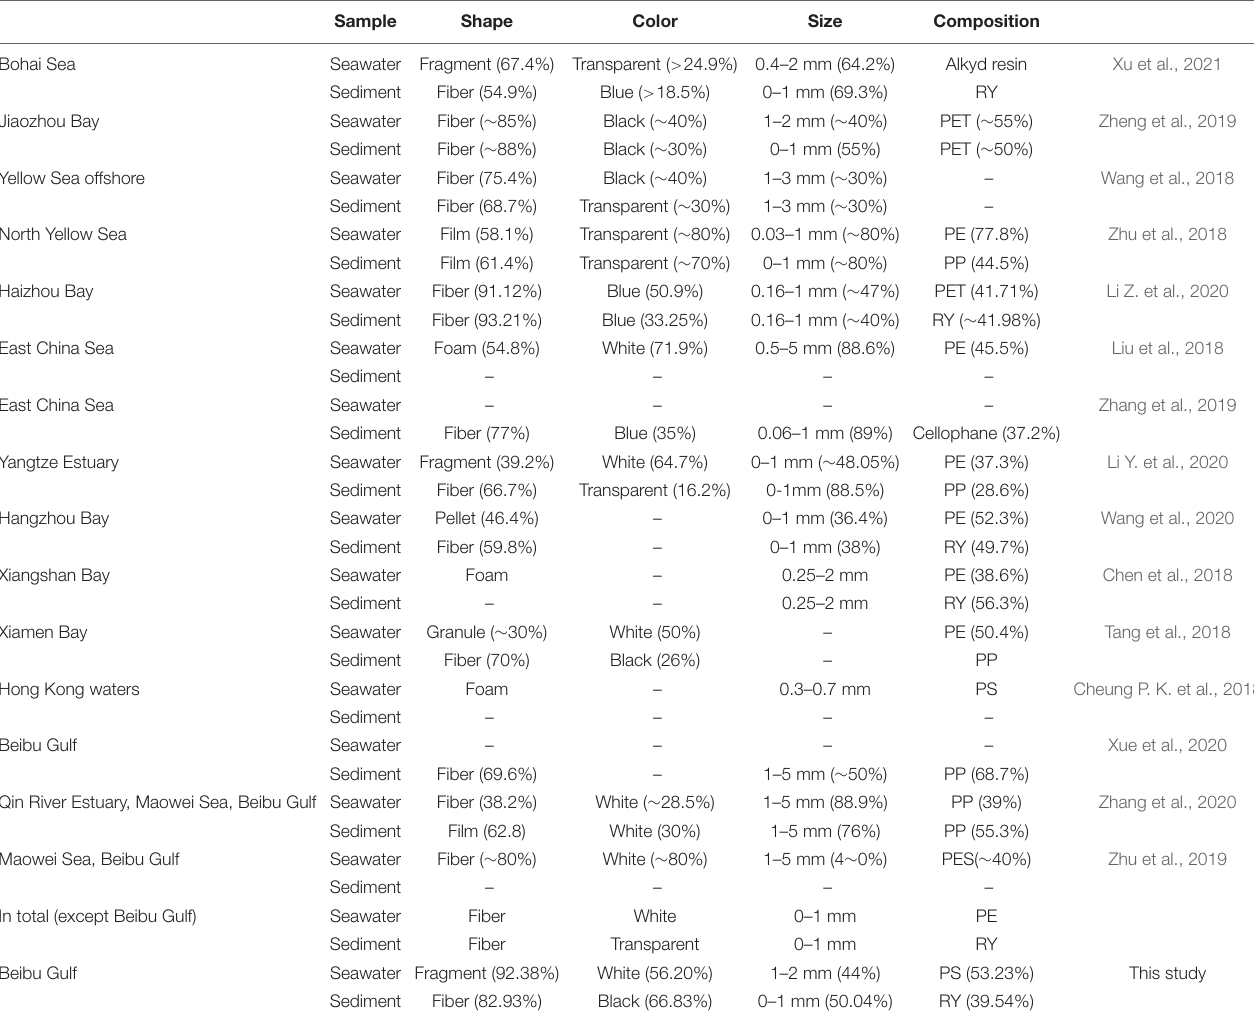
TABLE 3 | Main microplastic characteristics observed in surface water and sediment in Chinese coastal seas and selected similar bays in other country with comparable data (data published within the last 3 years, revised from Xu et al.,